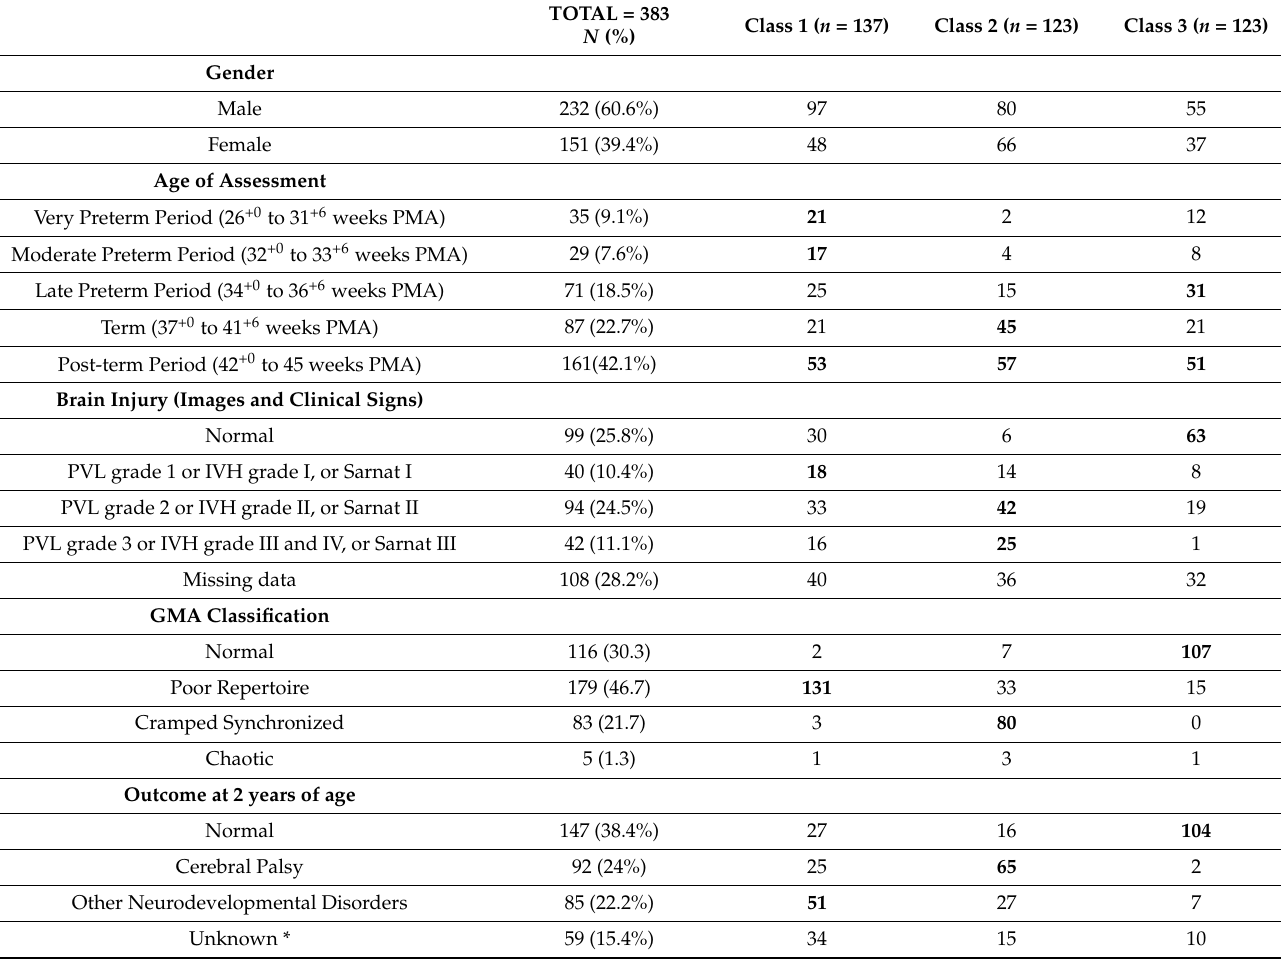
Table 1. Class detail and sample description by class